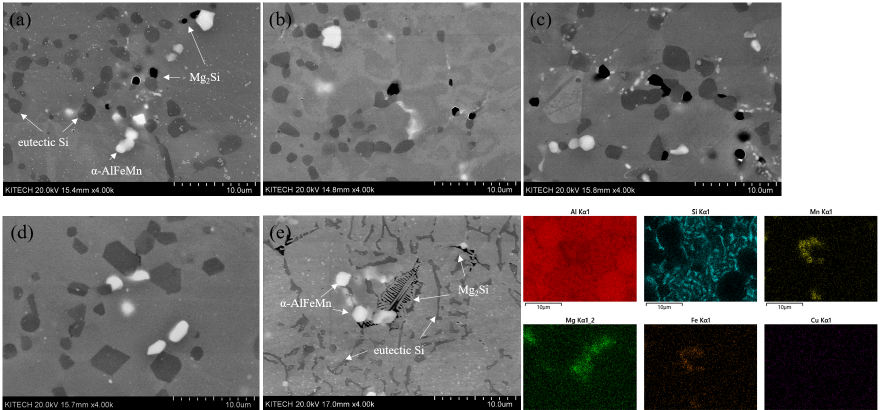
Figure 4. X-ray diffraction patterns of the as-cast and solution treated alloys: ( a ) X-ray diffraction patterns of as-cast ( b ) comparison of the as-cast and each solution treated alloys.